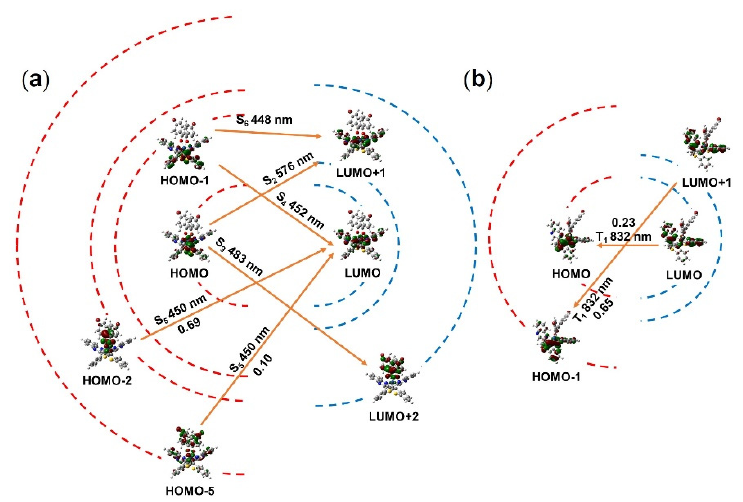
Figure 4. ( a , b ) Abridged general view of singlet and triplet transitions of complex 4 , respectively. The red dashed lines represent the HOMOs and the blue dashed lines represent the LUMOs (the transverse distances of the dashed lines only give a rough indication of FMO energy gaps). The orange arrows represent the transition between FMOs according to theoretical